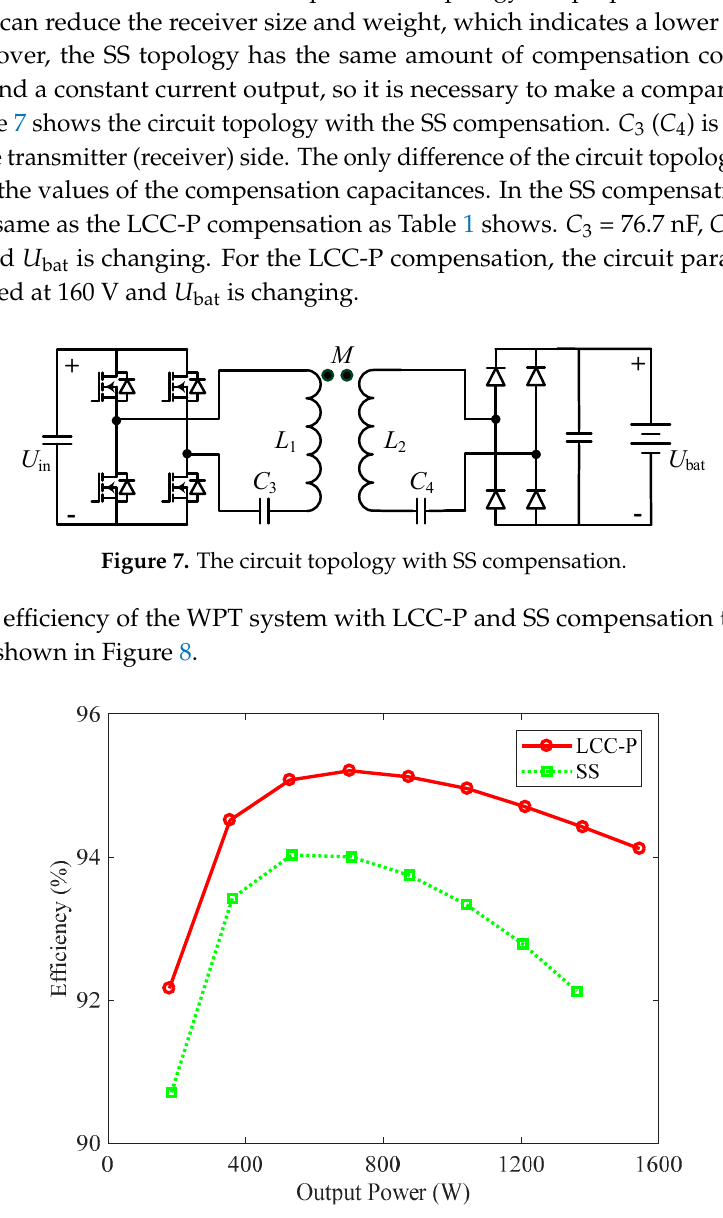
Figure 8. The system efficiency varying with the output power.